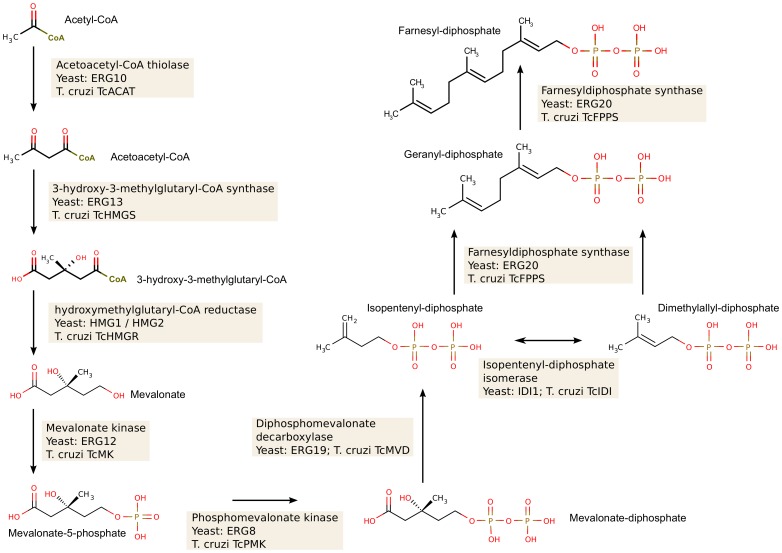
The T. cruzi isoprenoid biosynthesis pathway.The figure shows the metabolic steps leading to farnesyl-diphosphate, from acetyl-CoA, and the corresponding yeast and T. cruzi enzymes that catalyze these steps. Gene names used are those in Tables 1 and 2.